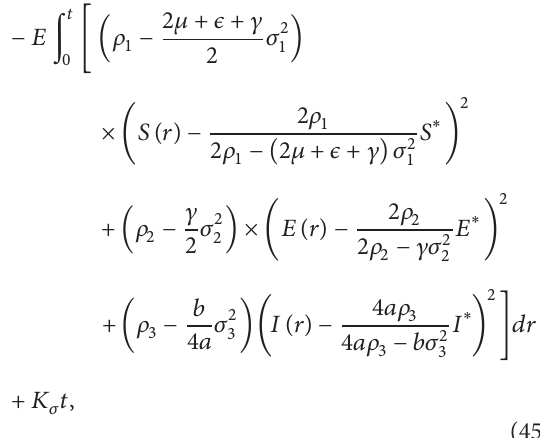
= 0.01 , 𝜎 = 0.02 , and 𝜎 = 0.02 1 2 3